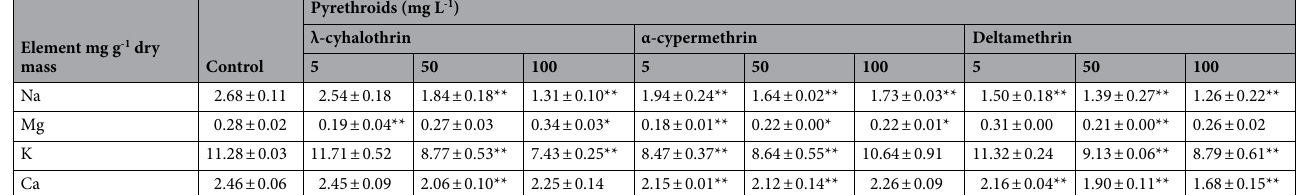
Element mg g -1 dry